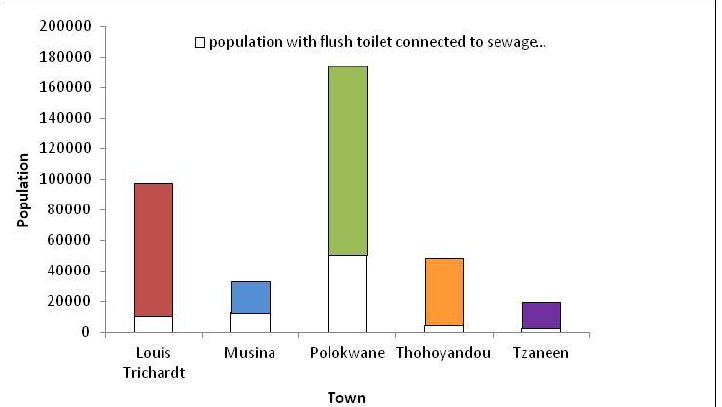
Figure 3. Population with flush toilet connected to sewage system for each town